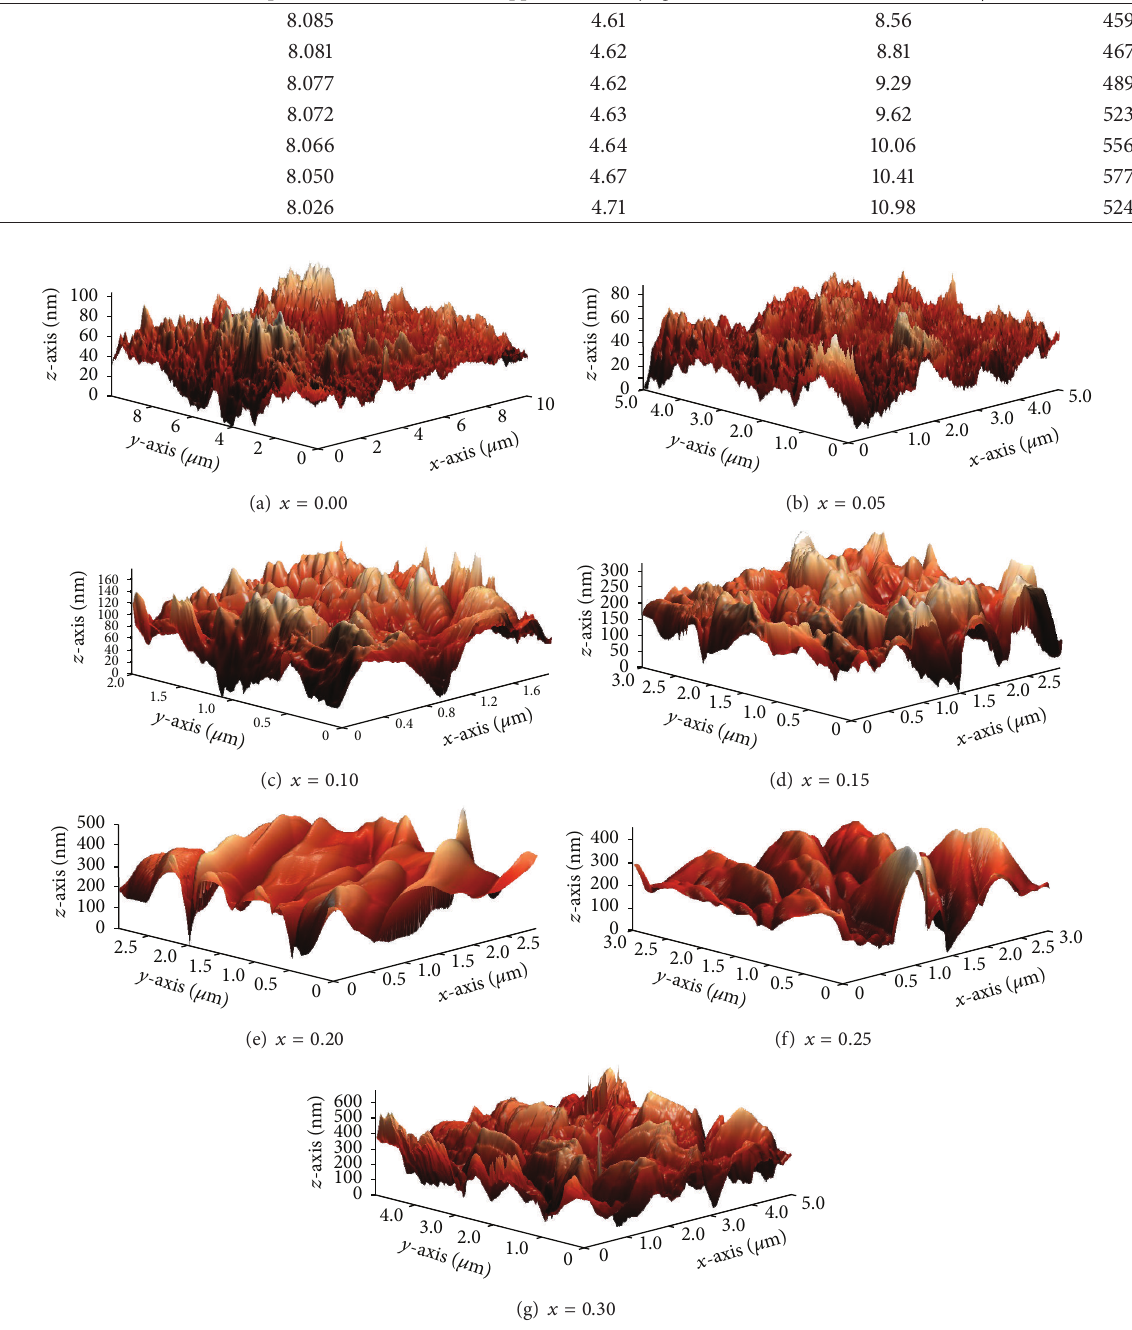
where 𝜀 𝑟1 and 𝜀 𝑟2 are the dielectric constants of phases with volumes V 1 and V 2 . Table 1 demonstrates the microwave dielectric properties of Ca 𝑥 Zn (1−𝑥) Al 2 O 4 thin films annealed at 500 ∘ C for 1 h. The densities and dielectric constants increased with 𝑥